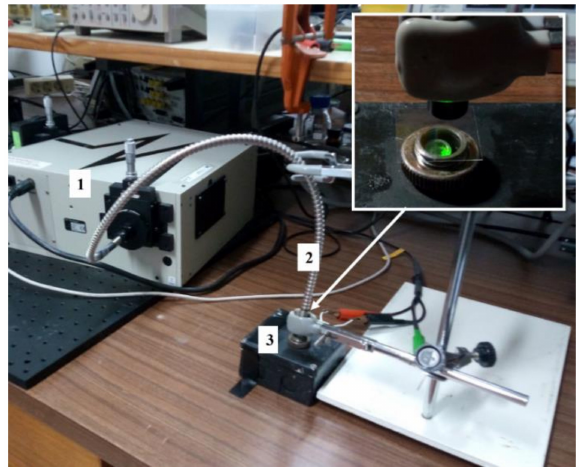
Figure 5. Optical setup created to measure the transmittance which includes: ( 1 ) monochromator (Newport 74125), ( 2 ) fused silica fiber-optic (Newport 77563), and ( 3 ) Si photodiode (Hamamatsu